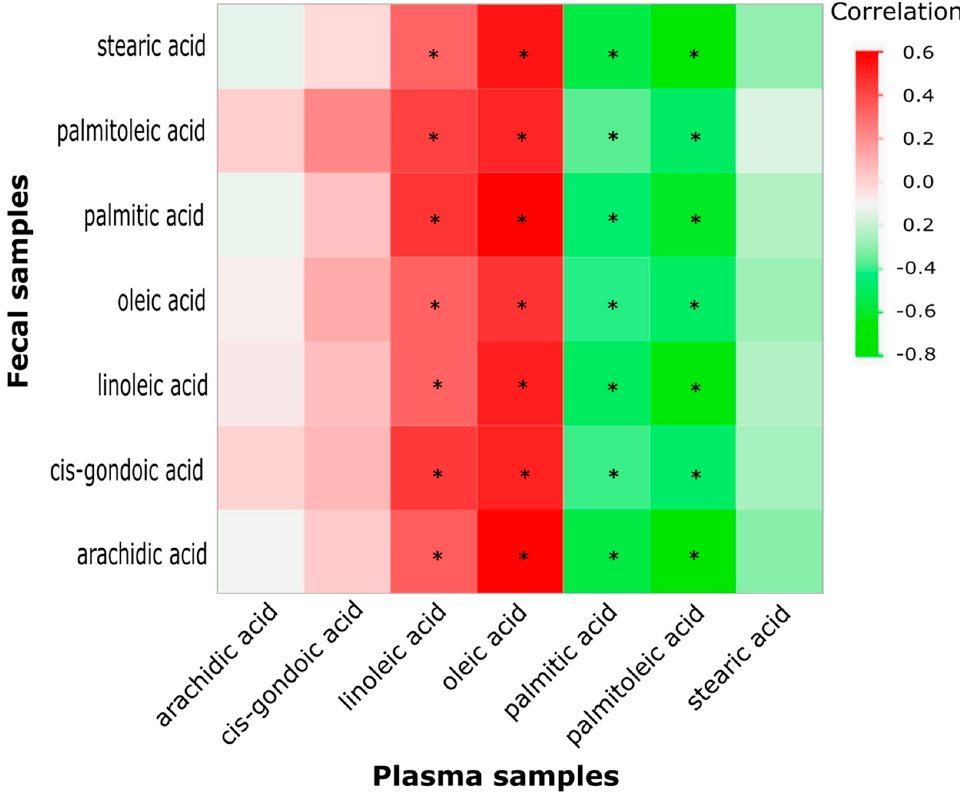
Figure 4. Correlation between the concentrations of key fecal and plasma fatty acids. The heatmap color stands for correlation coefficient r value. * p < 0.05, a significant FDR-adjusted correlation (n = 50).